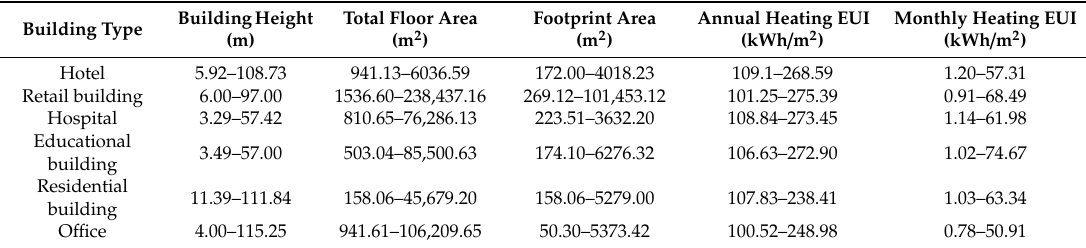
Table 2. Value range of parameters of selected buildings.